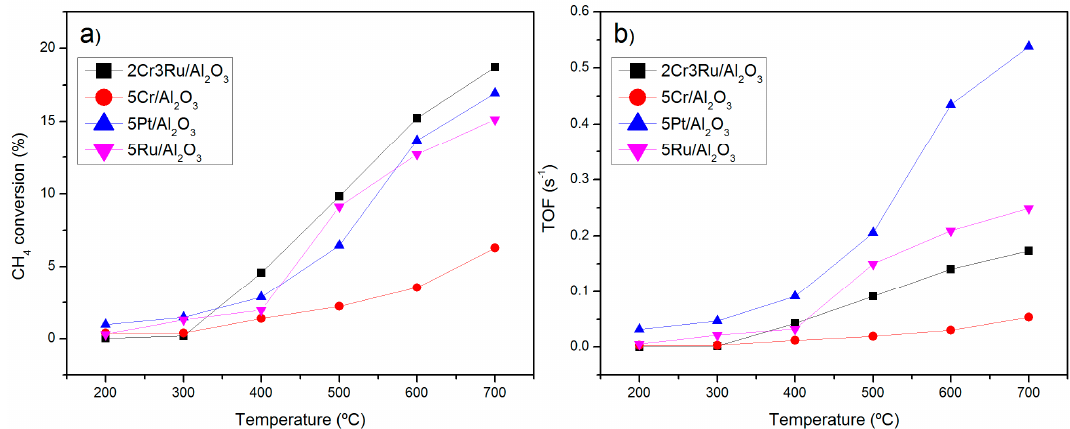
Figure 9. Effect of varying reactor temperature on activity of 5Pt, 5Ru, 5Cr, and 2Cr3Ru supported on Al 2 O 3 . ( a ) Plots of CH 4 conversion versus reactor temperature and ( b ) plots of TOF versus reactor temperature. Reaction conditions: feed gas O 2 /CH 4 volume ratio = 3/5, GHSV = 15,000 h − 1 , and reactor temperature = 200–700 °C. Note that an experimental error was ±1.5%, calculated from nine tests of 2Cr3Ru/Al 2 O 3 under the same conditions at 475 °C.